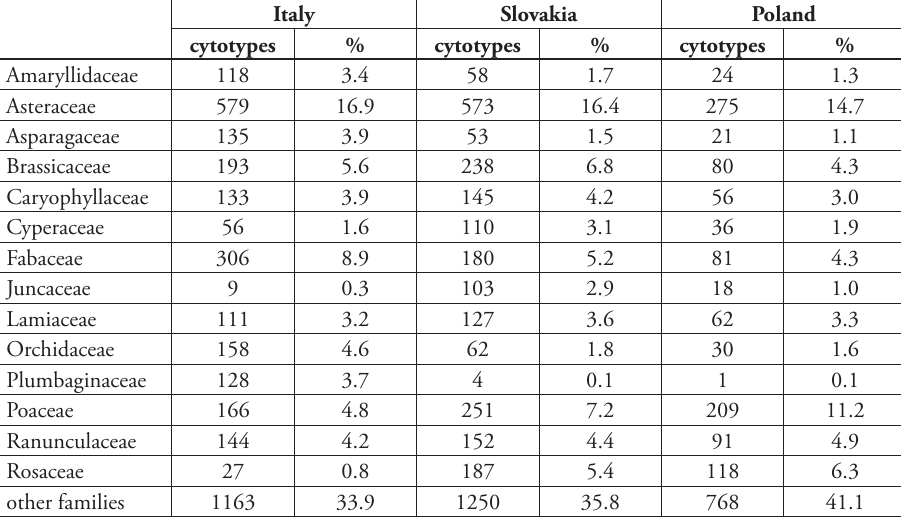
table 2. Most represented families in the three datasets (> 100 registered cytotypes in at least one country).